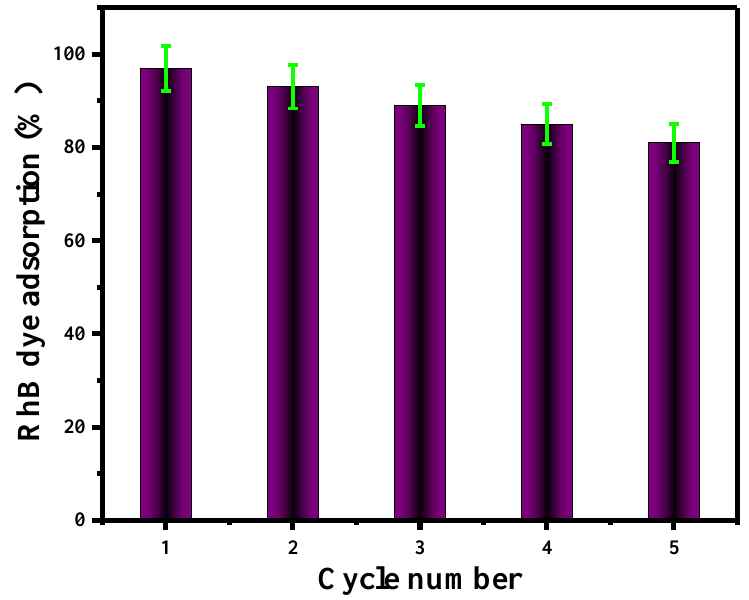
Figure 11. V@TiO 2 nanomaterial